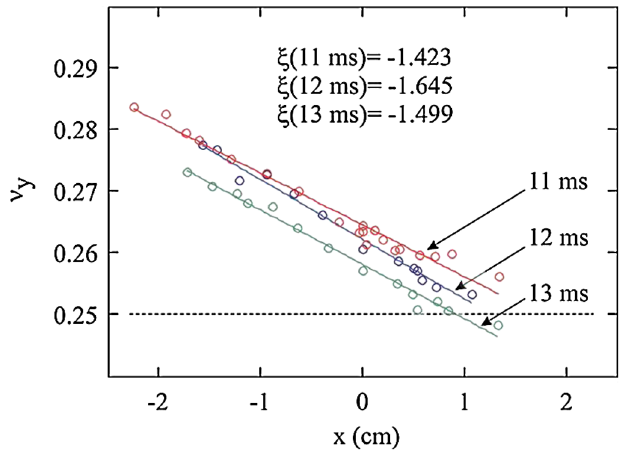
FIG. 7. (Color) Measured vertical chromaticities when instabil- ity occurs. x is the radial deviation from the reference position.